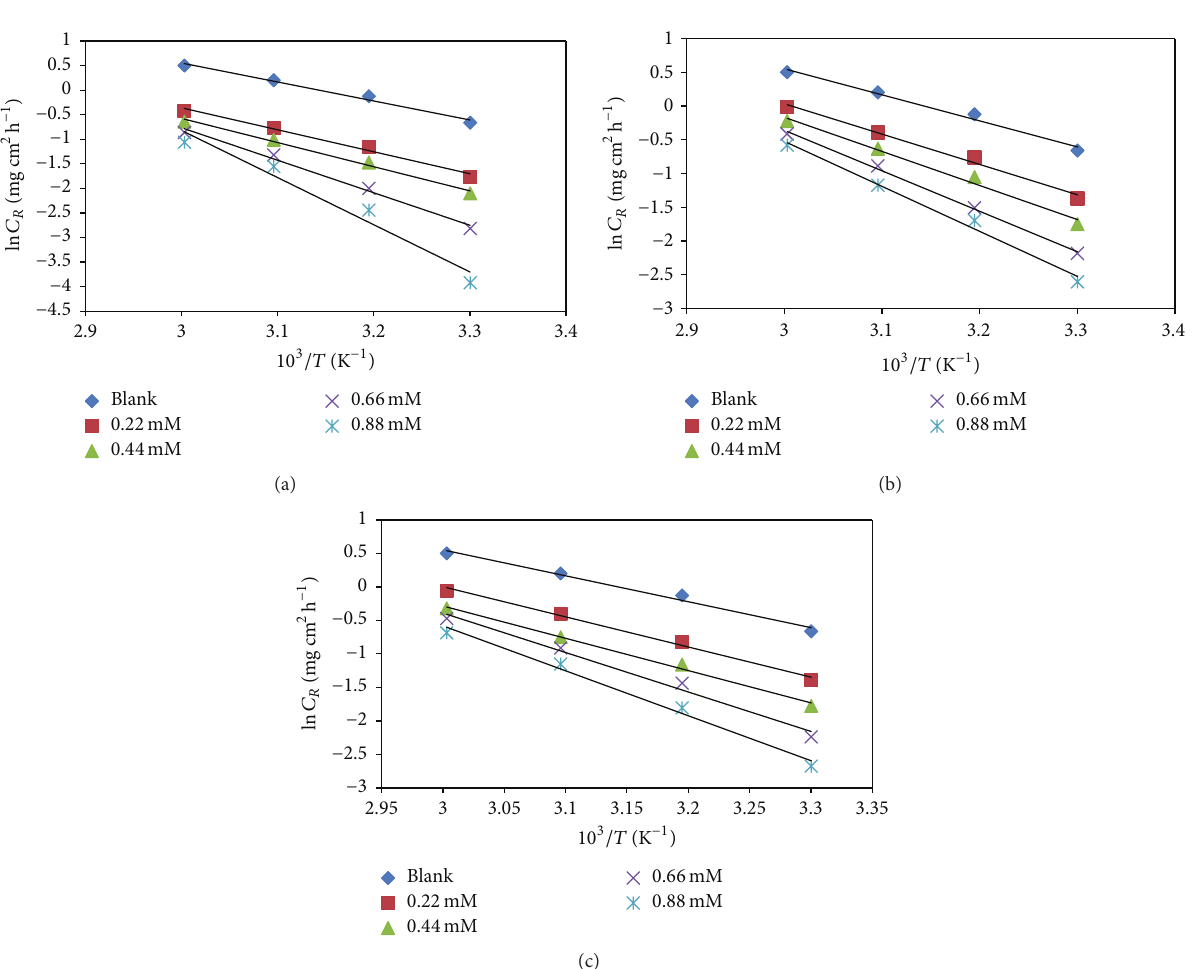
MS in the presence of 2-MTPH, 3-MTPH, and